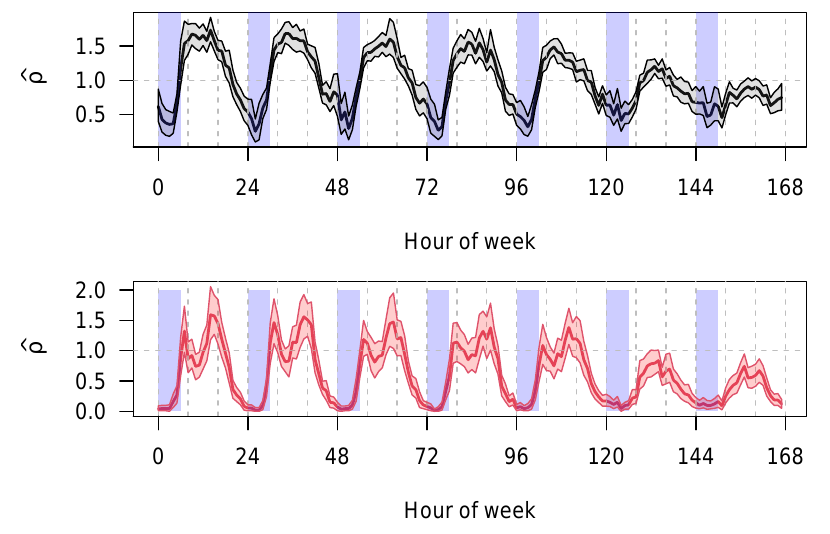
Figure 15. Risk index ρ as a function of the hour of the week for all crashes ( top , black) and the severe crashes ( bottom , red). The blue rectangles indicate the hours between 0 a.m. and 6 a.m., the area around the curves is the 99% confidence interval of the mean. They have been computed by